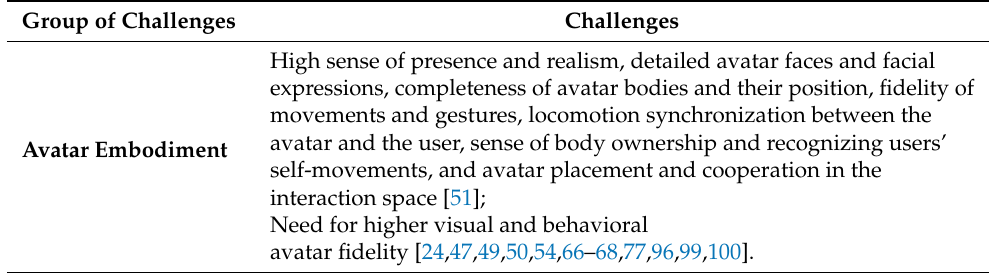
Table 4. Representation